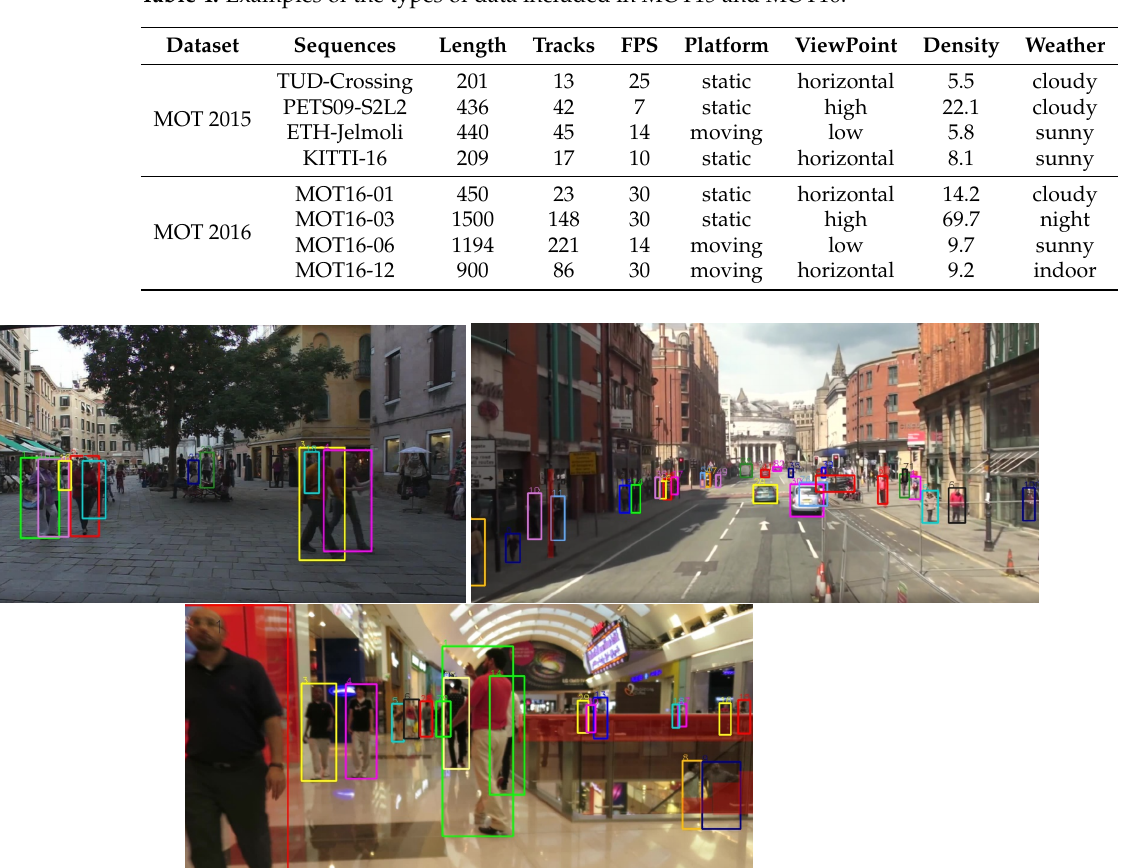
Table 4. Examples of the types of data included in MOT15 and MOT16.